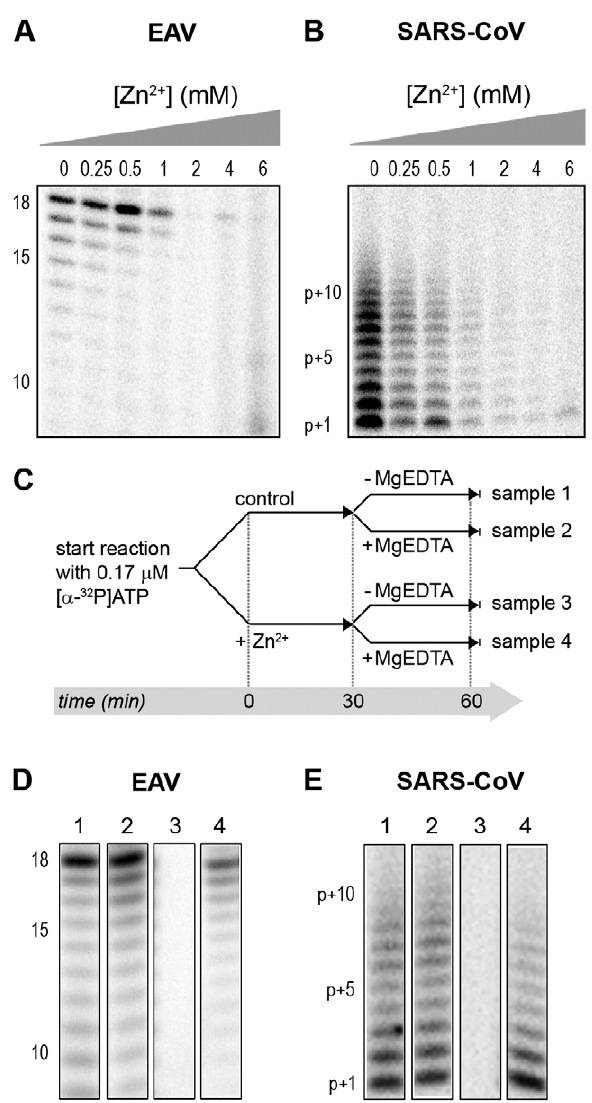
Figure 5. The activity of the RdRps of EAV and SARS-CoV is reversibly inhibited by Zn 2 + . RdRp activity of purified EAV nsp9 ( A ) and SARS-CoV nsp12 ( B ) in the presence of various Zn 2 + concentrations, as indicated above the lanes. ( C ) Schematic representation of the experiment to test whether Zn 2 + -mediated inhibition of RdRp activity could bereversedwithMgEDTA. RdRp reactions,eitheruntreated controls (sample 1 and 2) or reactions containing 6 mM Zn 2 + (samples 3 and 4) were incubated for 30 min. Both Zn 2 + -containing and control samples were split into two aliquots and 6 mM MgEDTA was added to sample 2 and 4. All reactions were incubated for an additional 30 min and then terminated. Reaction products of the RdRp assays with EAV nsp9 and SARS-CoV nsp12 are shown in ( D ) and ( E ), respectively. Numbers above the lanes refer to the sample numbers described under (C).